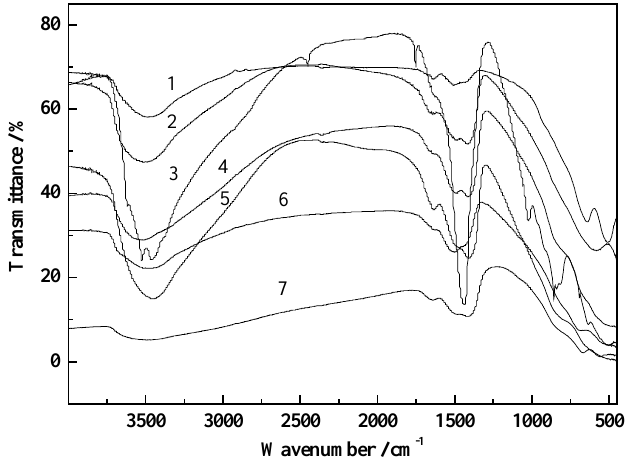
calcinating at 700 °C. +: CuO, ■: Mg(Al)O; ▼: ZnAl 2 O 4 , □: BaAl 2 O 4 .